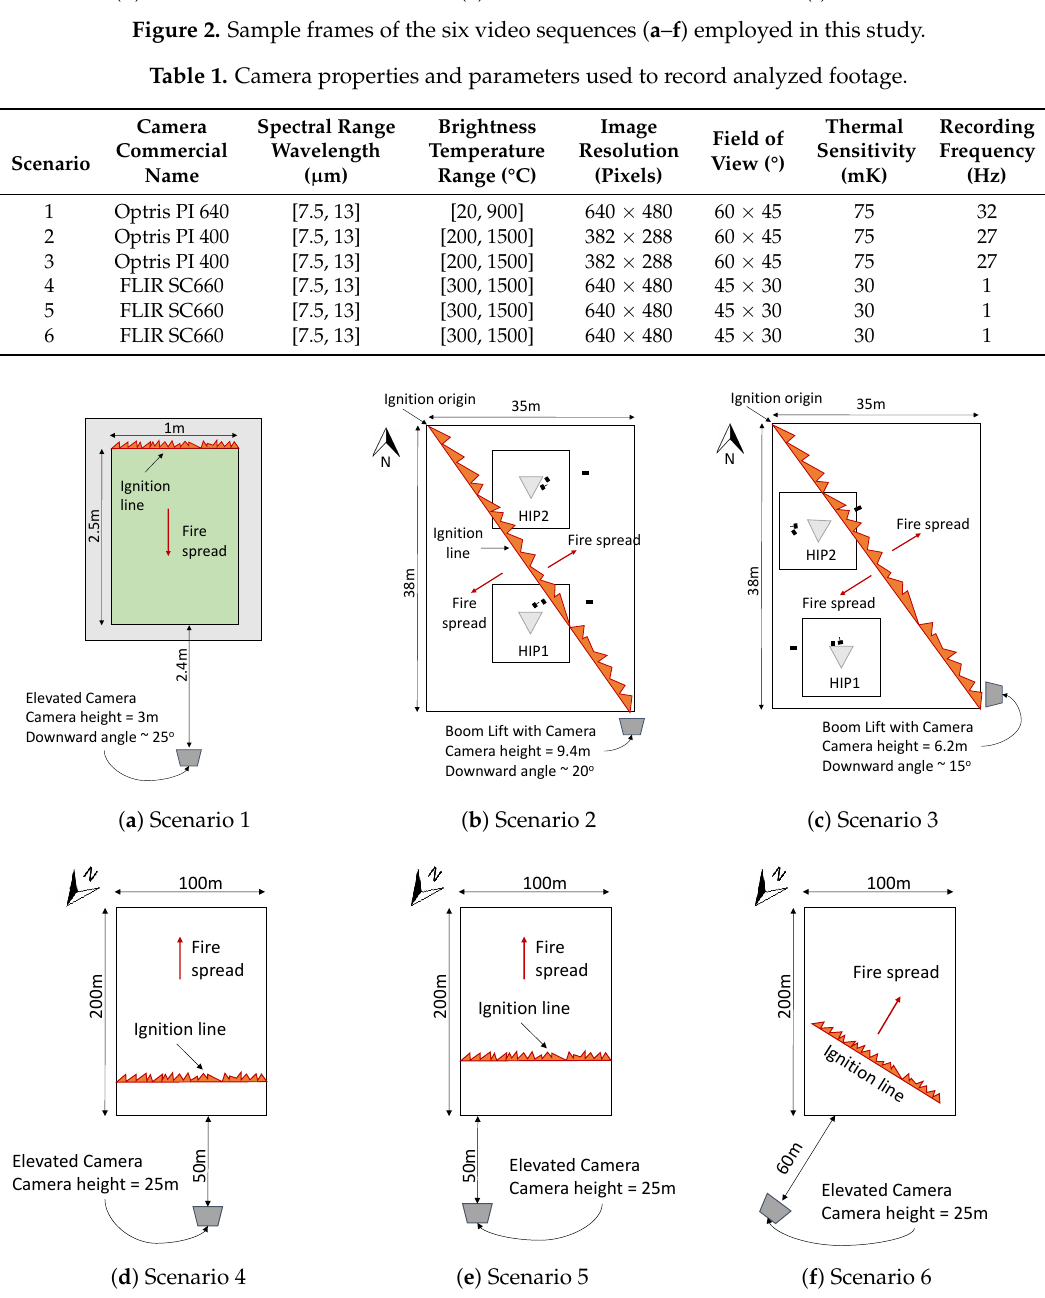
Figure 3. Experimental setups used to record the six video sequences ( a – f ) employed in this study. Crown fire did not occur in any of the presented scenarios. Still, this dataset can be considered representative of the typical use of thermal IR cameras in forest fire